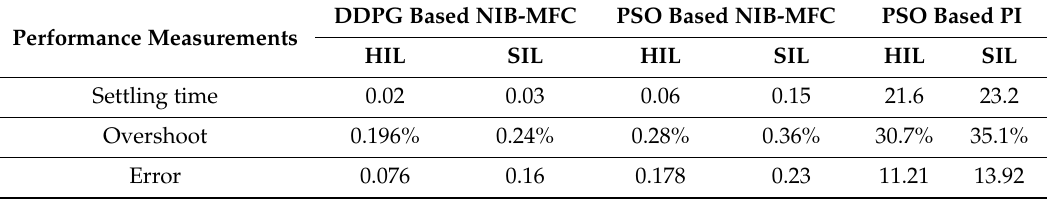
Figure 10. The trend of average reward in the SIL environment.